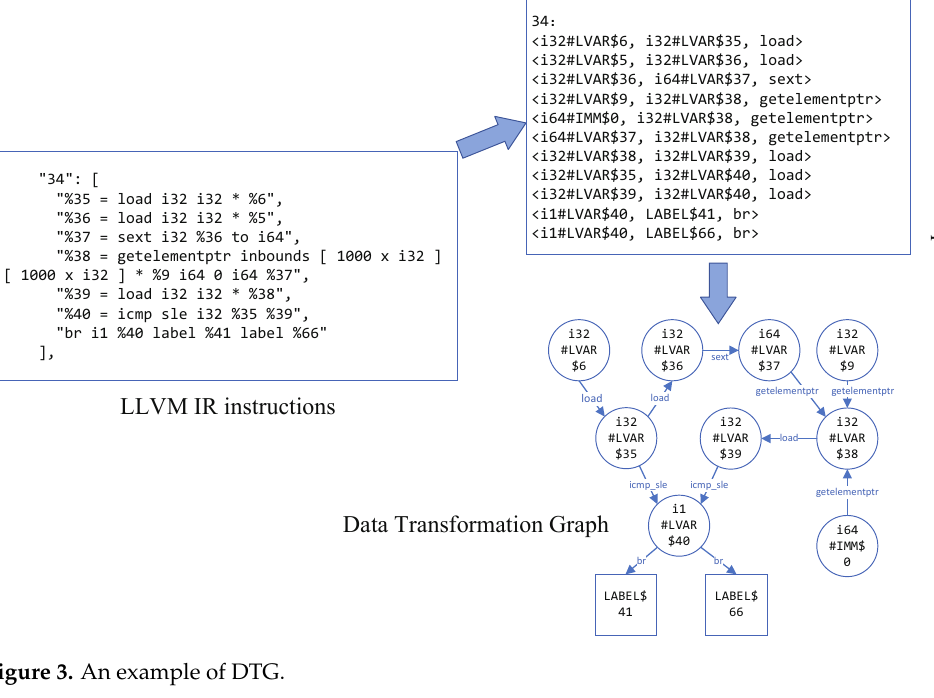
Figure 3. An example of DTG.